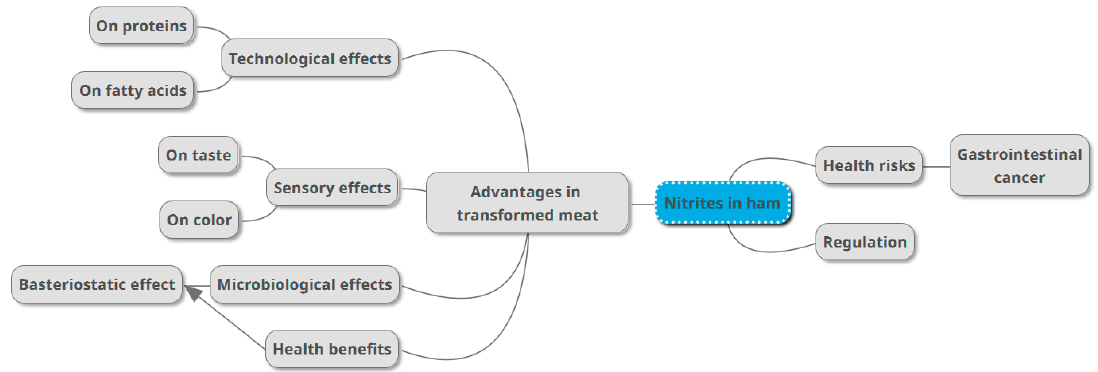
Figure 1. Overview of the risks and benefits associated with nitrite addition to processed meat.